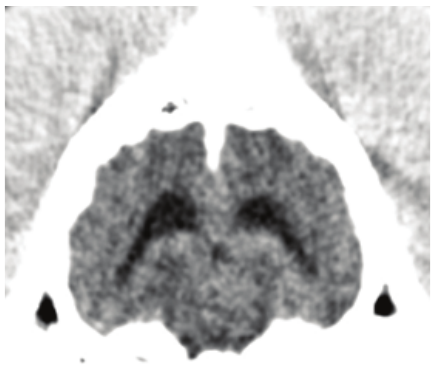
Figure 2: Transverse CT image of the brain, 30 days later, showing the absence of the lesion and the almost complete resolution of the ventricular